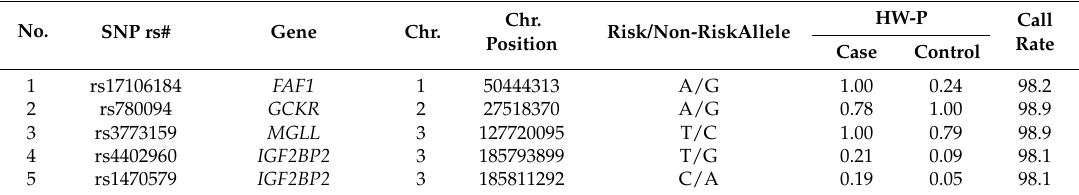
Table 1. Information of the selected type 2 diabetes mellitus (T2DM)-related single nucleotide polymorphisms